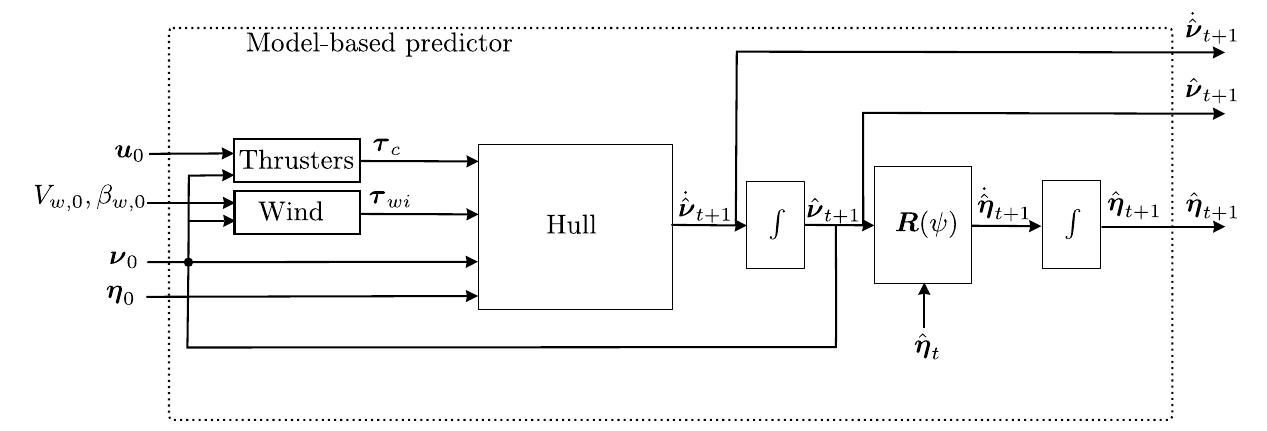
Figure 1: Model-based predictor